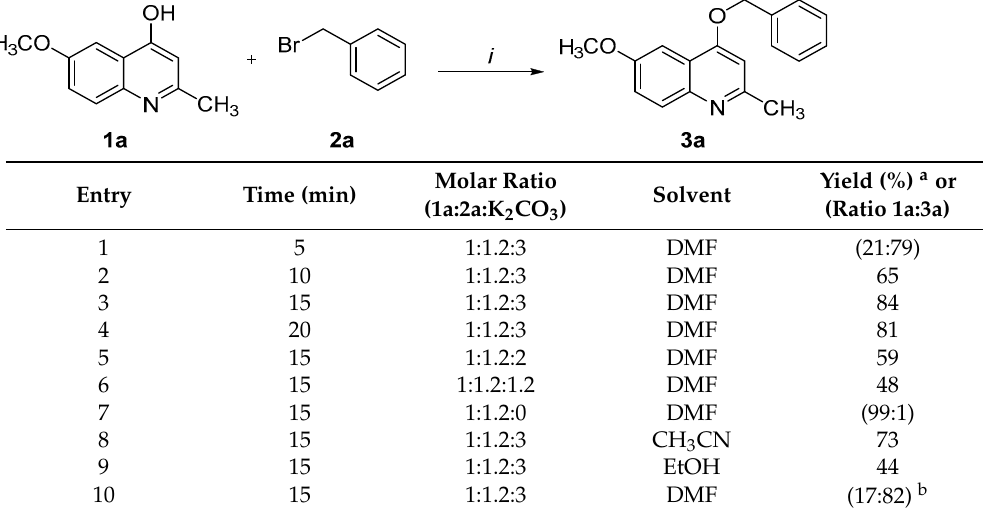
Table 1. Reagents and conditions: i = K 2 CO 3 , solvent, ultrasound or conventional, 5–20 min. a Isolated yields. b Reaction performed under conventional thermal heating (120 ◦ C).